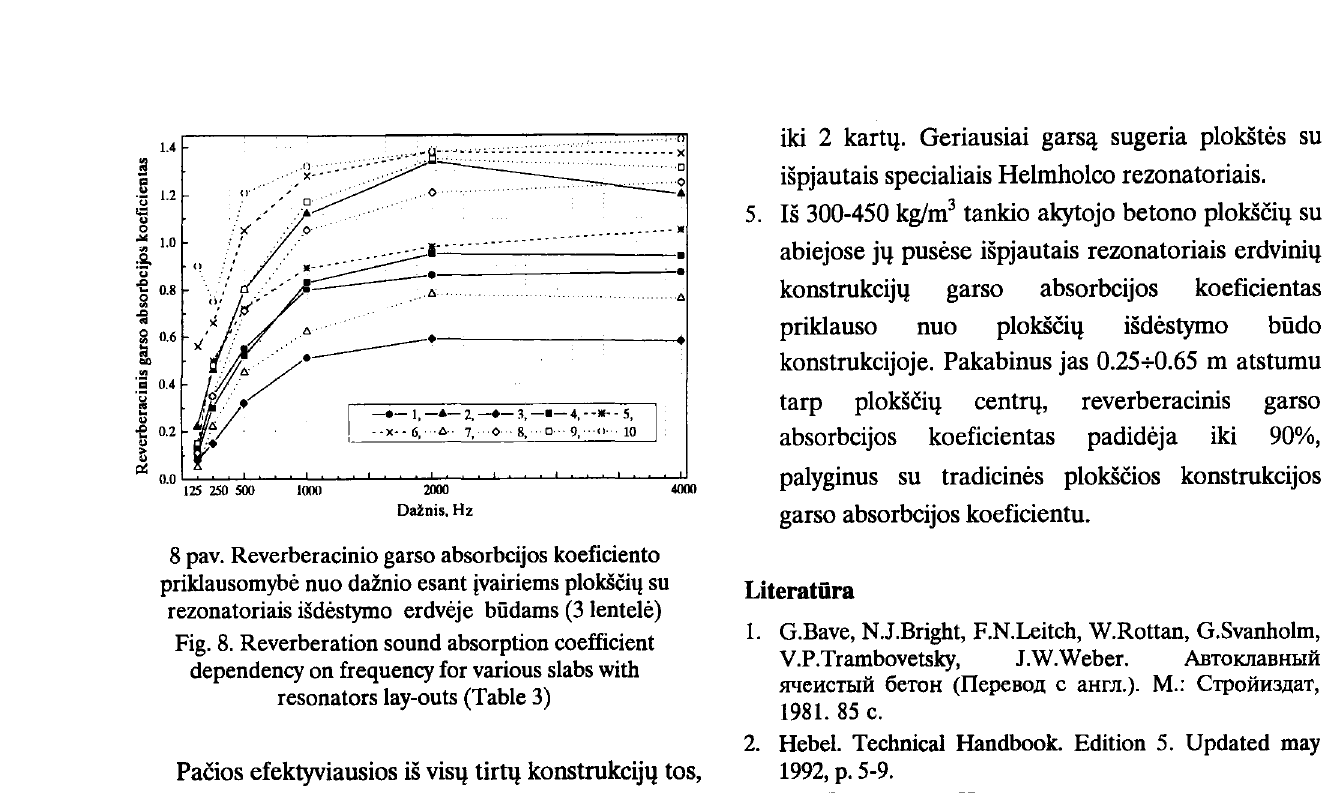
Fig. 8. Reverberation sound absorption coefficient dependency on frequency for various slabs with resonators lay-outs (Table